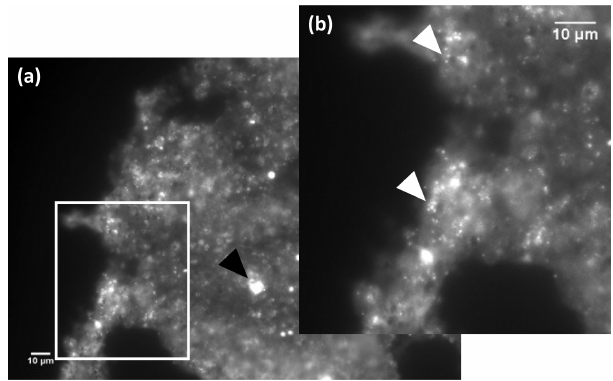
Figure 2. Fluorescence micrograph of a DAPI-stained, decalcified G. bulloides cell. (a) Diffuse autofluorescence not associated with DNA-stained inclusions can be observed throughout the cytoplasm. The black arrow highlights an example of the bright regions, 3– 10µm in size, that correspond to vacuoles containing condensed prey items. The many ∼ 1µm diameter brightly stained globular structures that occur throughout the cell are consistent with the pres- ence of intracellular bacterial cells. The white rectangle denotes the area magnified in (b) and shows examples (white arrows) of these DNA-containing, bacteria-sized structures and their cytoplasmic lo-